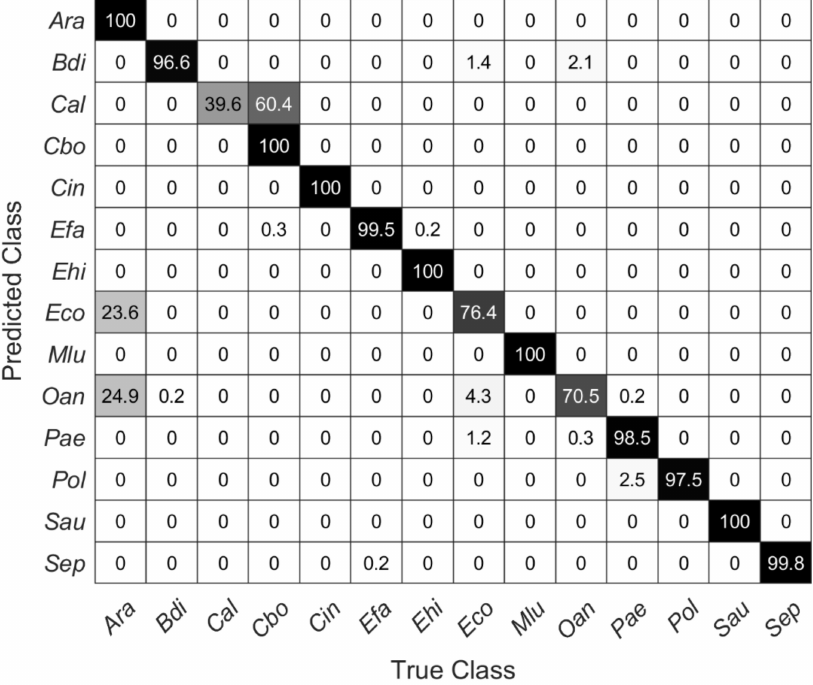
Figure 6. Confusion matrix showing the percentage of true and false predictions for Raman spectra of each species recorded on stainless-steel slides by using the SVM model with the first 20 PCs of data collected on silver mirror slide (585 ± 40 spectra per